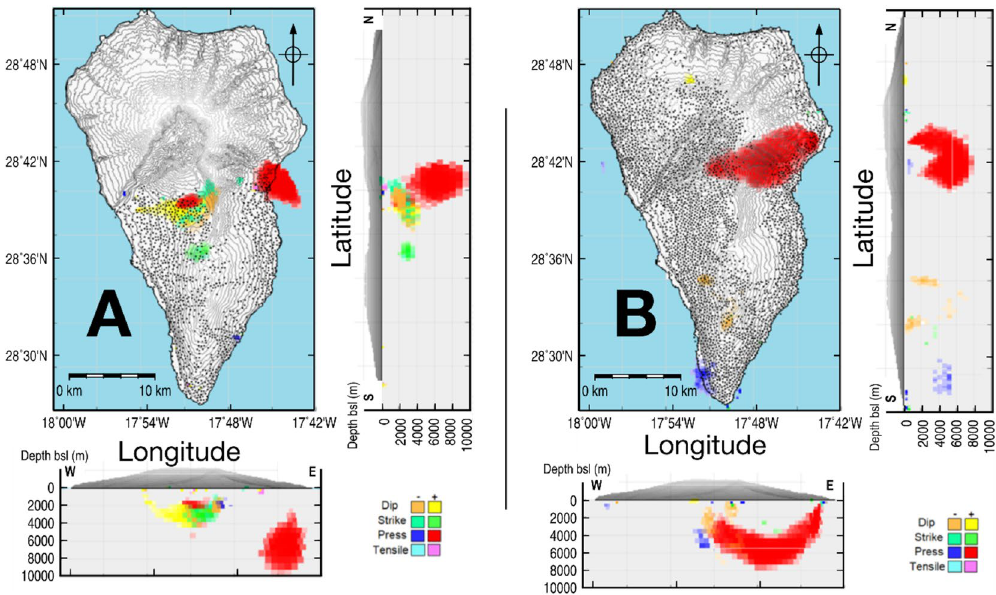
Figure 3. Adjusted model for deformation sources. ( A ) Sources adjusted for the period 2006–2010, and ( B ) for the period 2017–2020. Each time period panel includes planar, E-W vertical and N-S vertical views of significant sources. See color code for the type of source and magnitude. Dots denote the location of ascending and descending LOS deformation data. Matlab (www.mathw orks.com) and GMT (www.gener ic-mapin -tools .org) softwares were used to create this